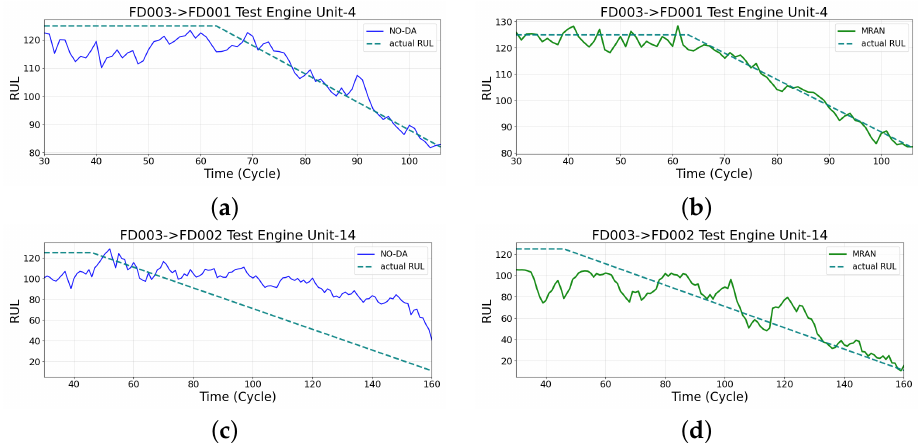
Figure 12. The source domain is FD003, and ( a ) is the prediction result of FD001 without domain adaptation. ( b ) FD001 prediction result after domain adaptation. ( c ) Prediction results of FD002 without domain adaptation. ( d ) FD002 prediction result after domain adaptation.